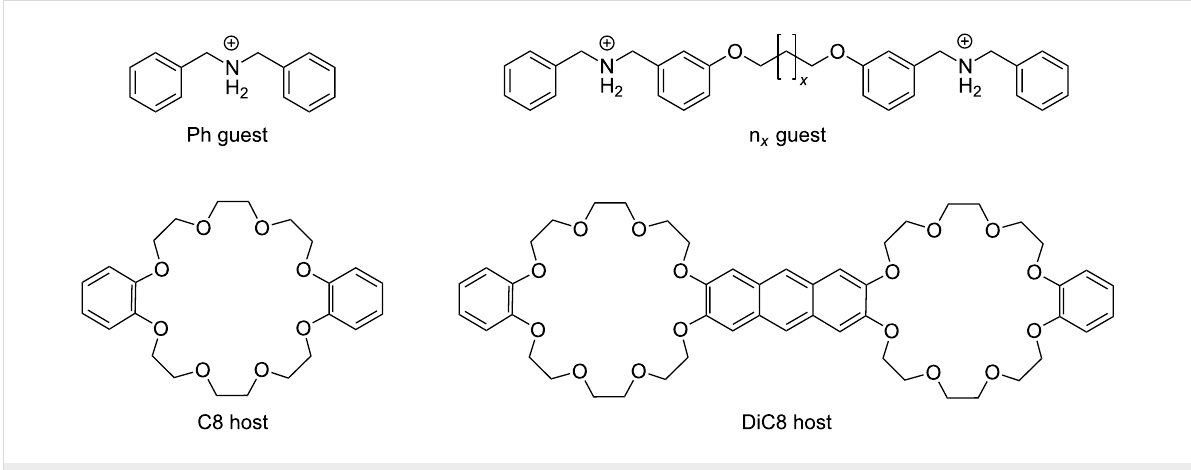
Figure 1: Structures of the mono- and divalent guest and host molecules. The linker in the divalent guest molecule is varied with x = 0, 1 or 2.